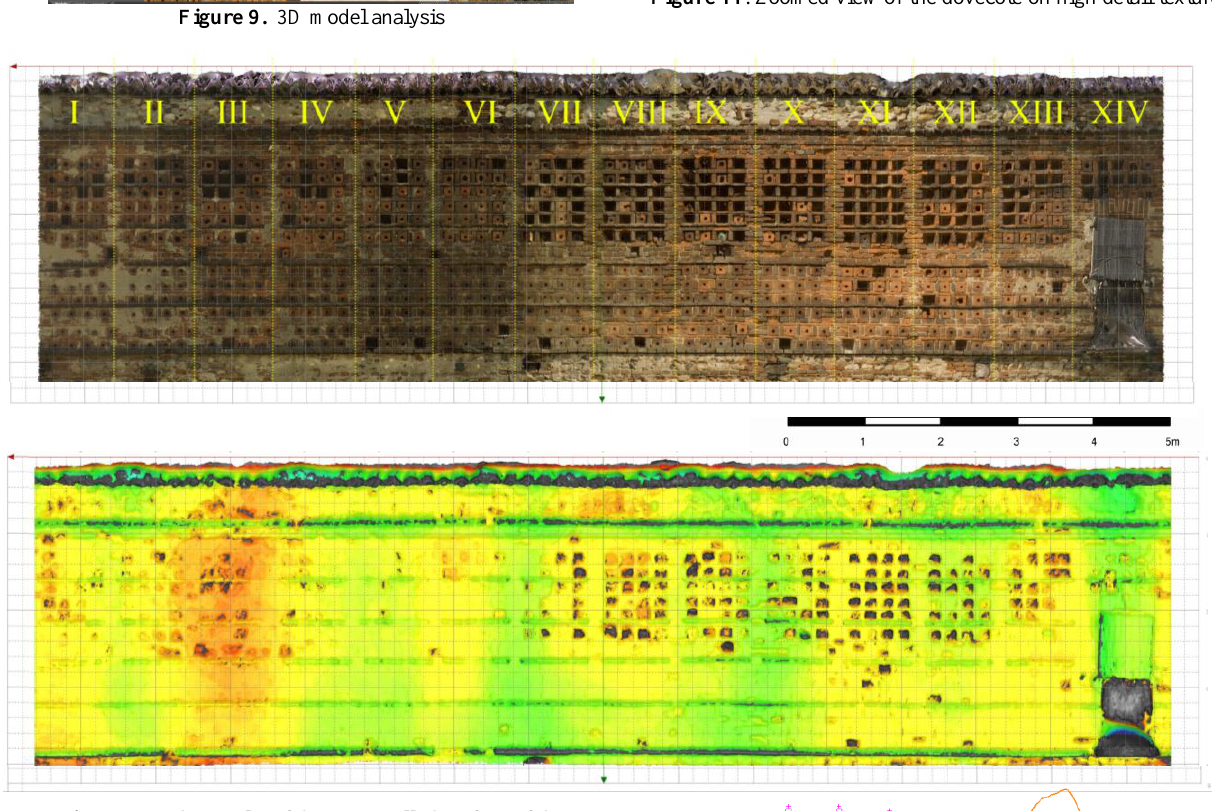
Figure 10. The results of the 2D unrolled surface of the dovecote, where are pinpointed the characteristic quadrants with particular square holed bricks. Next, the 2D unrolled surface of the 3D model analysis by surface comparison between the photogrammetric mesh and the best fitting cylinder